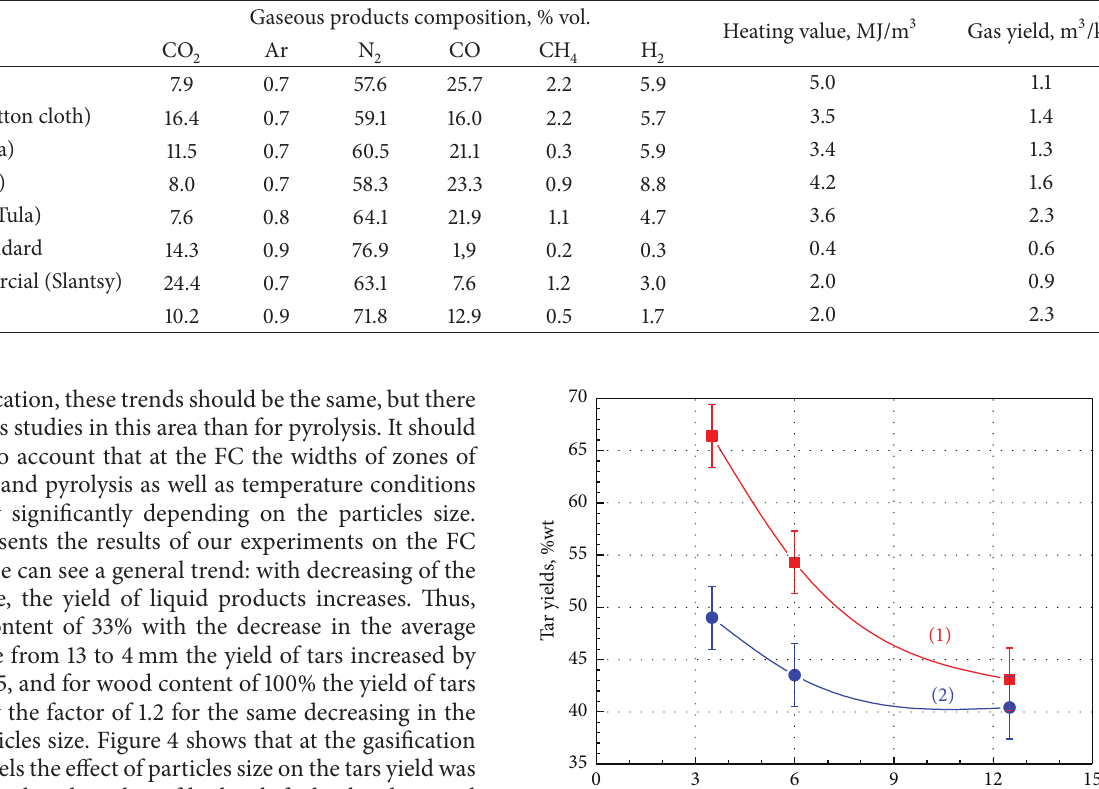
Table 2: The composition of gaseous products in air gasification of various fuels.